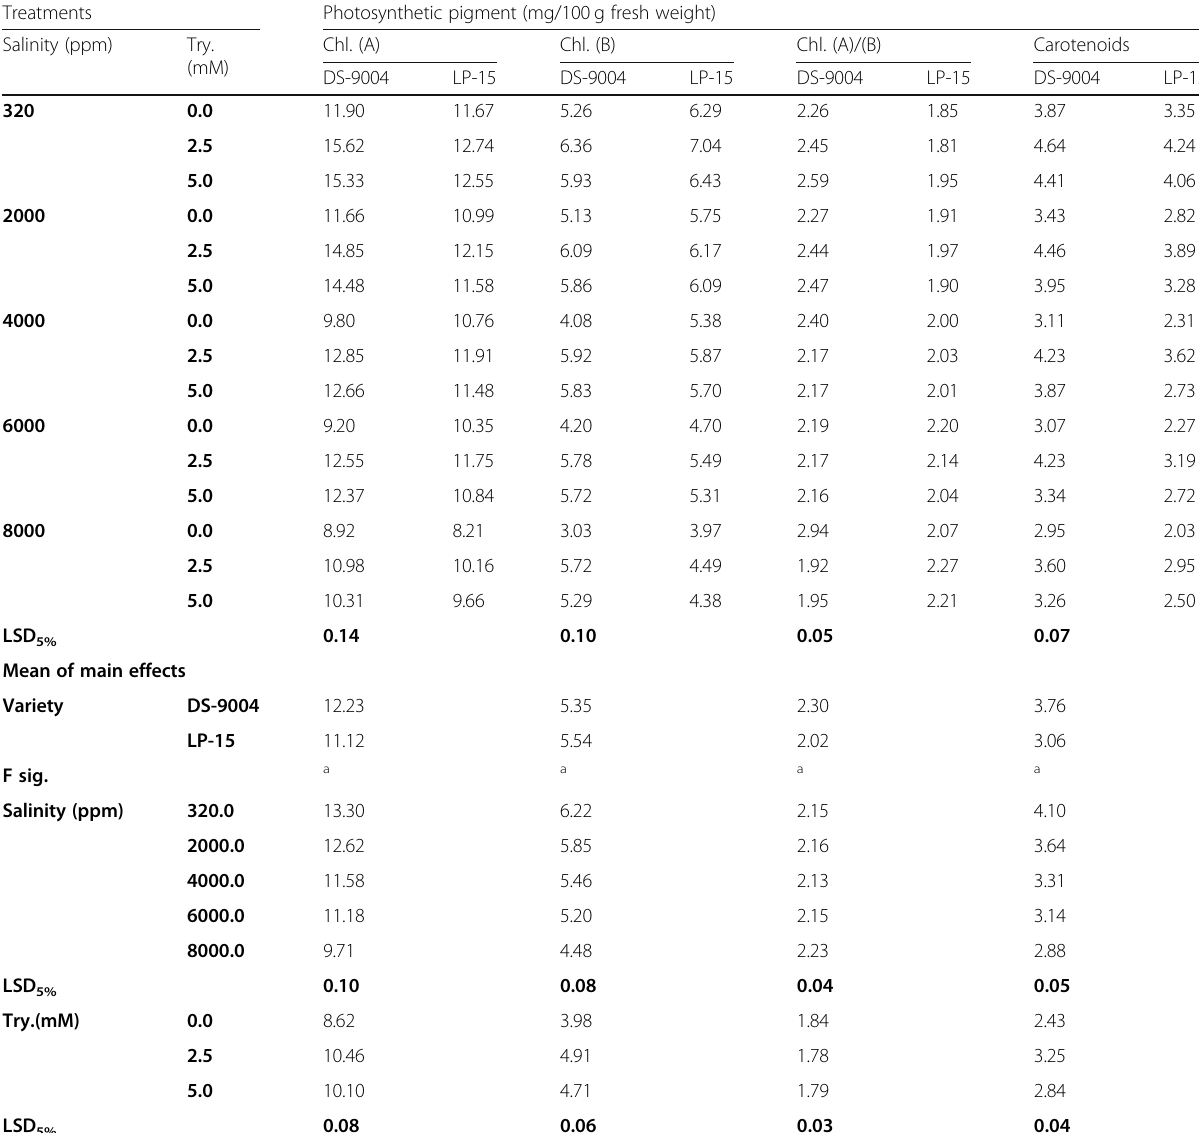
Table 3 Effect of pre-soaking two sugar beet seed cultivars with tryptophan and irrigated with different salinity levels on photosynthetic pigment contents (mg/100 g fresh weight) at 75 days after sowing Treatments Photosynthetic pigment (mg/100 g fresh weight) Salinity